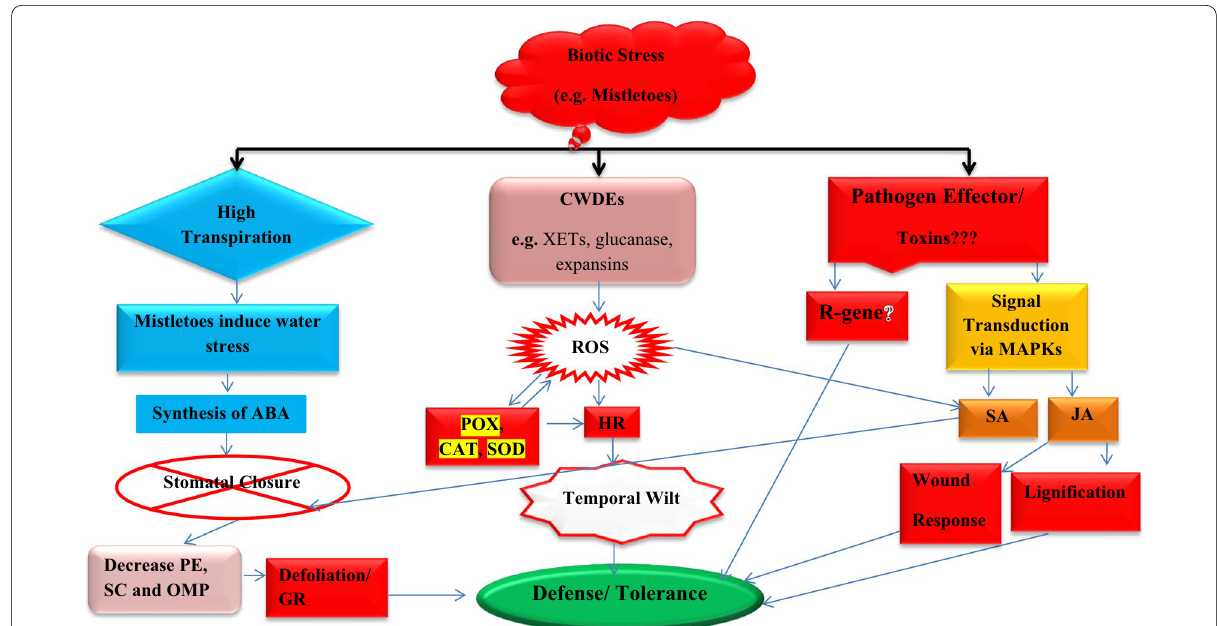
Fig. 4 Hypothetical hormonal and drought stress-mediated response against mistletoes. ABA, abscisic acid; CWDE, cell wall-degrading enzymes; PE, photosynthetic efficiency; OMP, organic mass production; SC, sugar cleavage; GR, growth retardation; HR, hypersensitive reaction; CAT catalase, POX, peroxidase, SOD, superoxide dismutase; XETs, xyloglucan endotransglycosylases; ROS, reactive oxygen species; JA, jasmonic acid; SA, salicylic acid; MAPK. mitogen activated protein